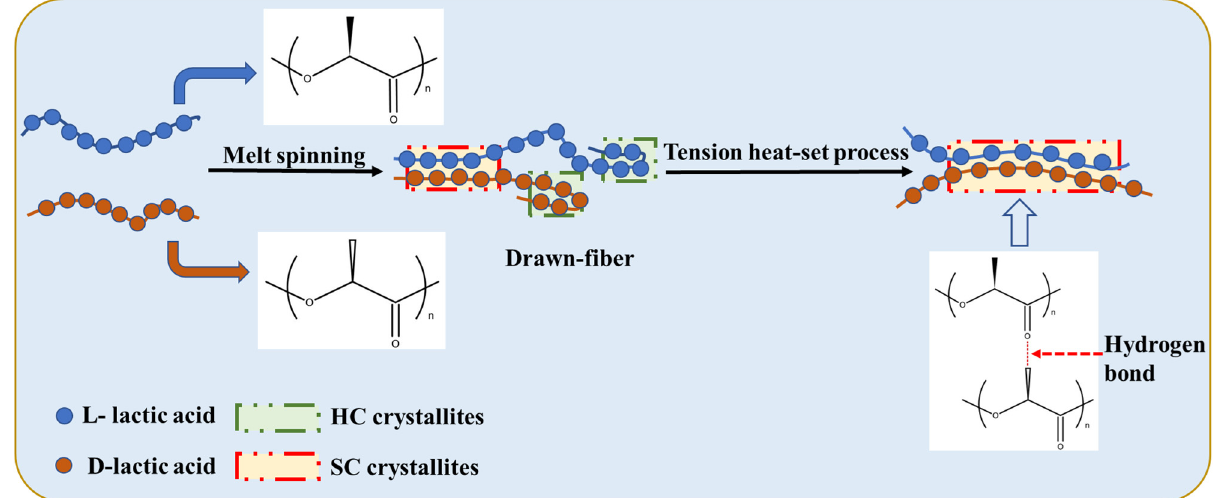
Figure 2. Schematic of stereo-complexation process for PLLA/PDLA fiber.